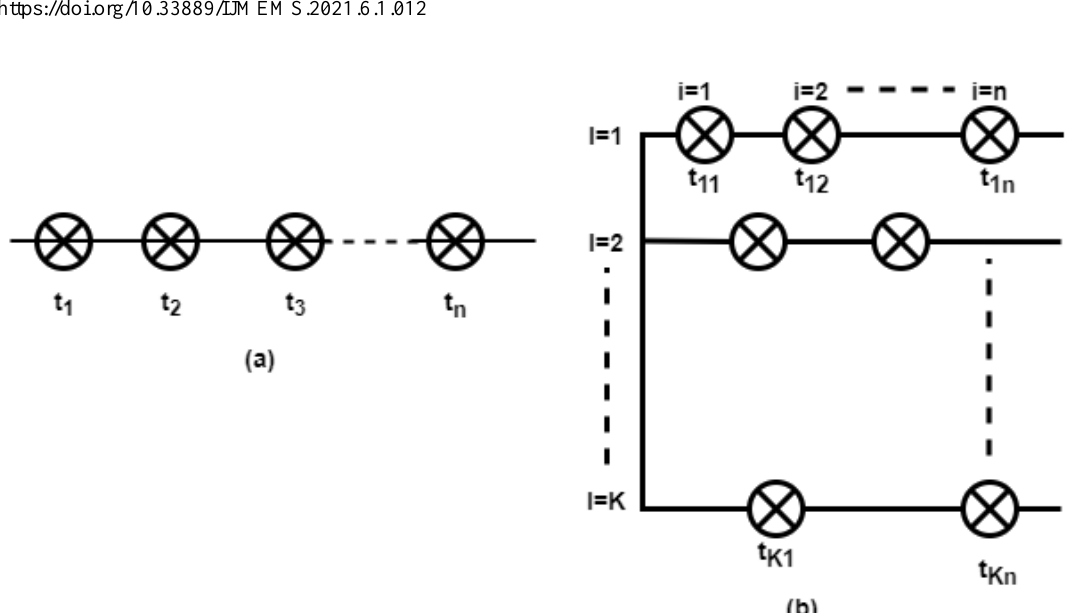
Figure 1. (a) Single repairable system, (b) Multiple repairable